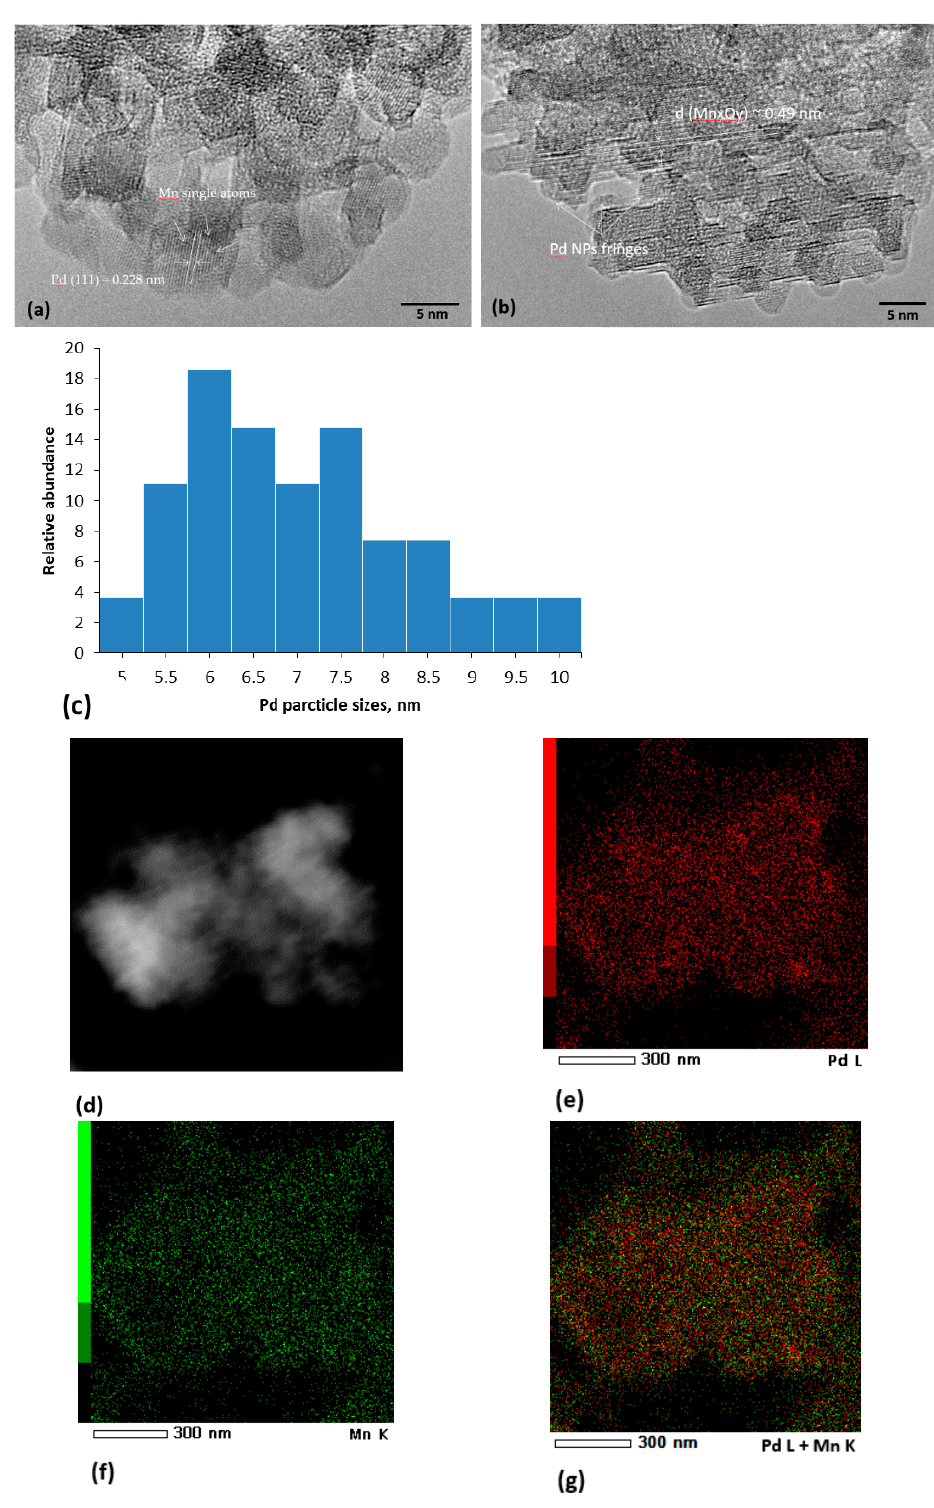
Figure 3. TEM imaging of the sample 4: ( a , b ) TEM image; ( c ) particle size distribution; ( d ) STEM image; ( e ) Pd mapping (L line); ( f ) Mn mapping (K line); ( g ) Pd (L) + Mn (K) mapping